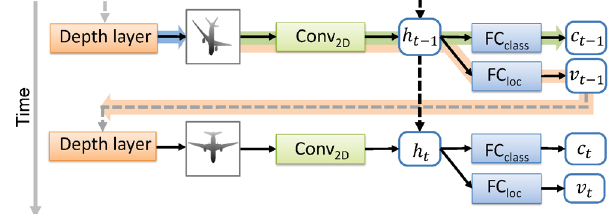
Fig. 1 Our recurrent attentional model. The dashed arrows indicate information flow across time steps while the solid ones represent that within a time step. The bold arrows underline the data flows of the three subnetworks, i.e., depth layer (DL, blue), 3D spatial transformer networks (3D-STN, orange), and shape classifier (SC, green).